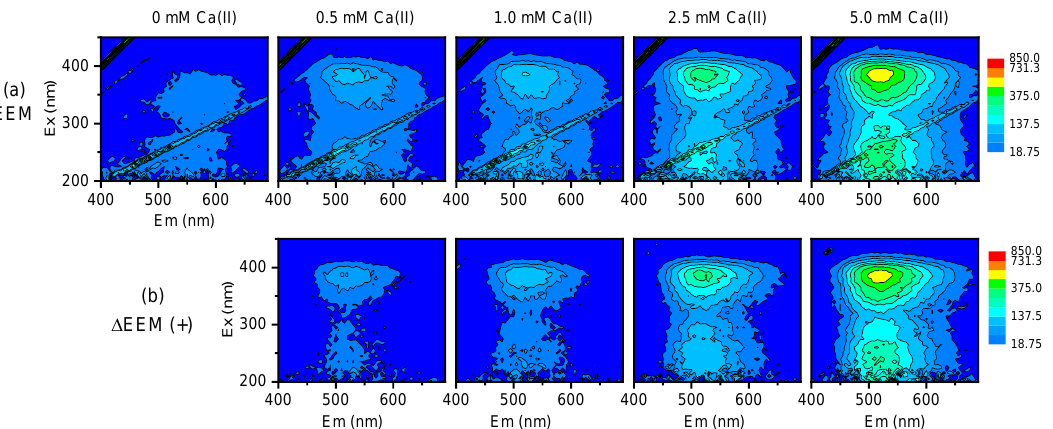
Figure 5. Fluorescence excitation-emission matrix (EEM) of TC with increasing Ca(II) concentrations (top panel, a ) and EEM of fluorescence variation ( ∆ EEM) by Ca(II) (bottom panel, b ). ∆ EEM ( + ) indicated the fluorescence was enhanced by Ca(II) addition.